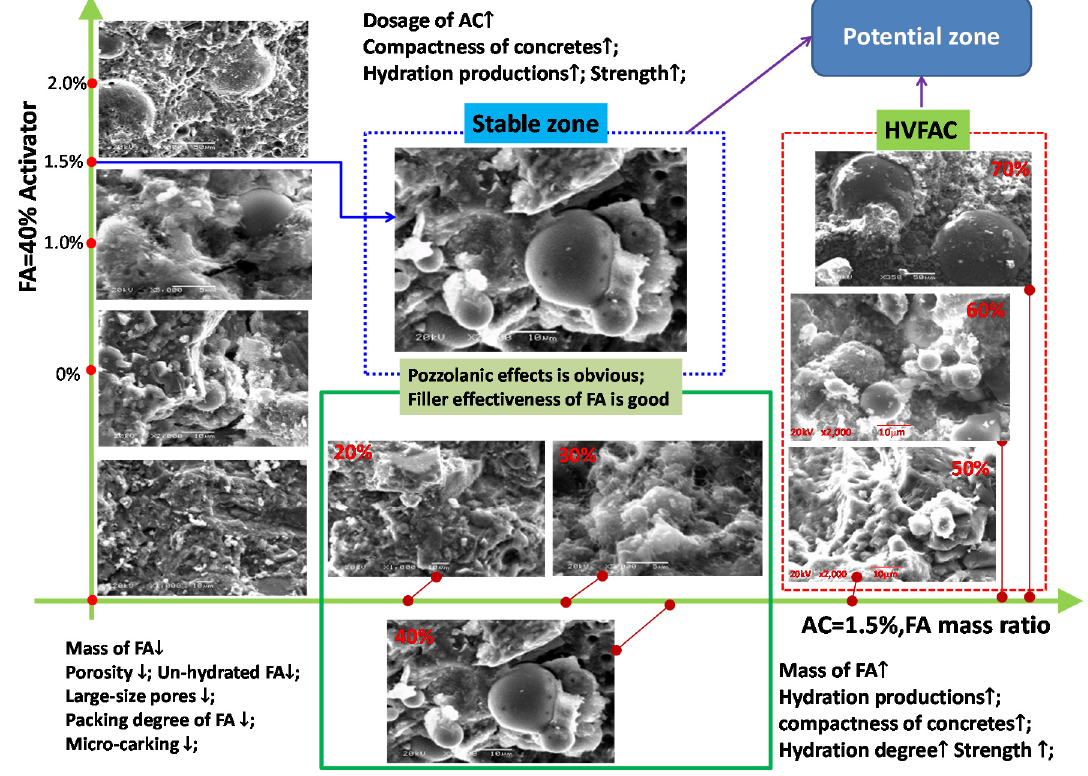
Figure 13. Microstructures vs. properties of FACs.